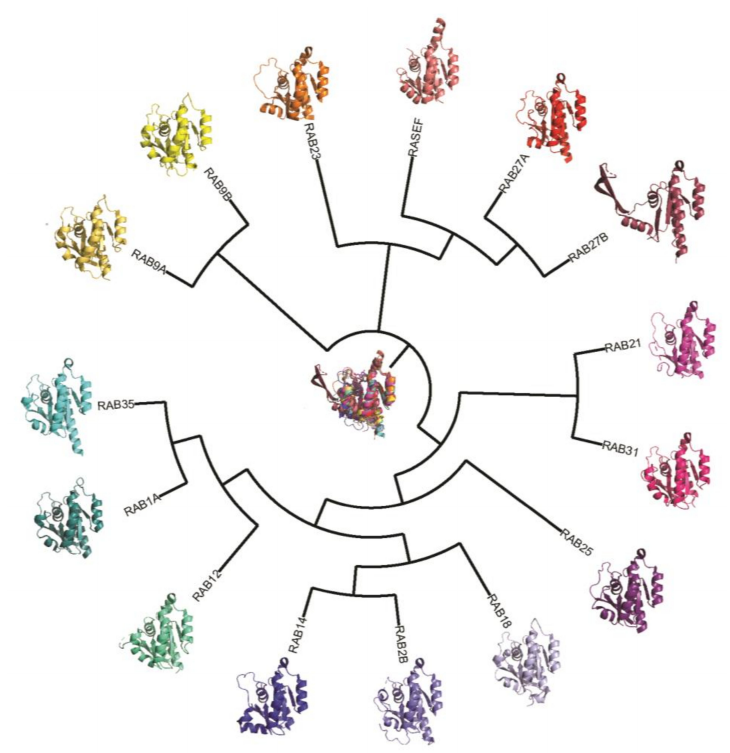
Figure 3. Phylogenetic tree of selected human Rab GTPases involved in apoptosis. Structures and phylogenetic trees of selected Rab proteins discussed in this review. Structure images were produced using Pymol from the protein data bank (PDB) structures (2F7S, 20CB, 4QXa, 1Z22, 2P5S, 6HUF, 1YZT, 2FGS, 2A5J, 1Z0F, 1X3S, 2IL1,